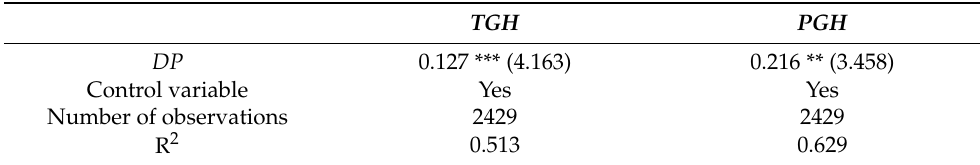
Table 5. Test results of the average effect of the degree of rural households’ part-time farming on grain output. TGH PGH DP